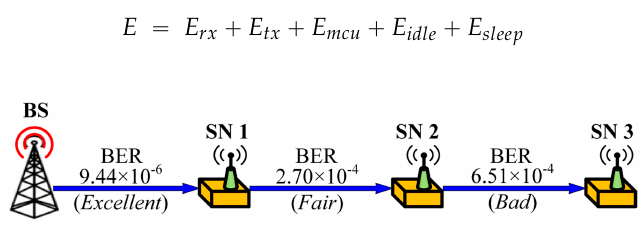
Figure 8. The probability of false positive in the Bloom filter.